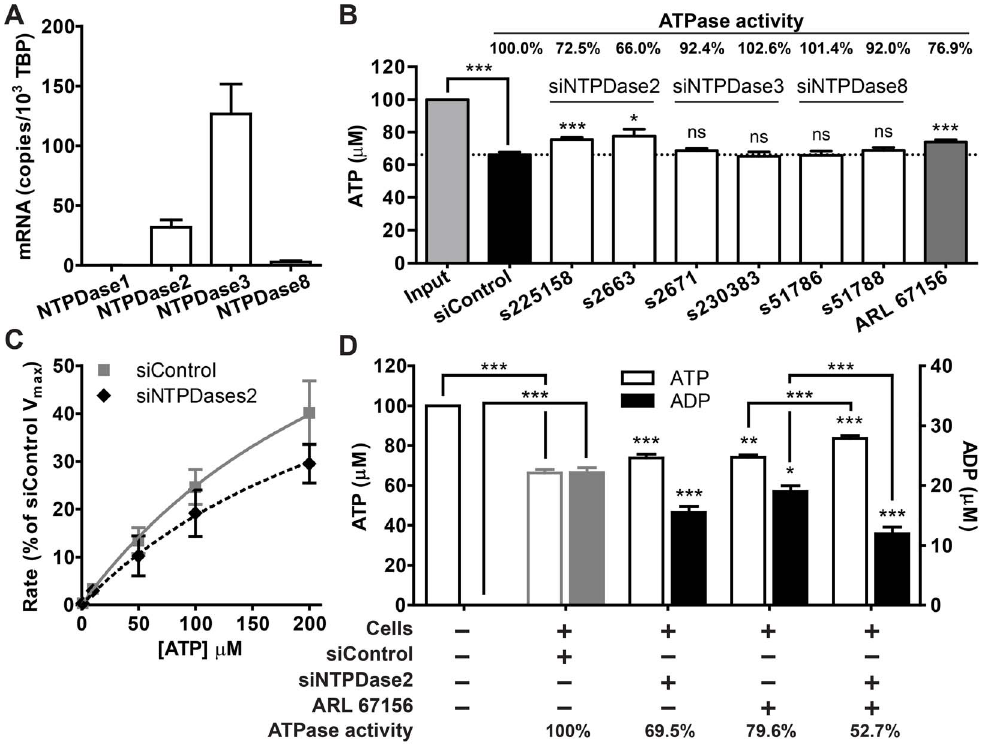
Figure 2. HaCaT cells express NTPDase2 that hydrolyzes extracellular ATP and accumulates ADP. (A) The relative mRNA levels of four surface-located NTPDases in HaCaT cells as determined using real-time PCR. Bars denote mRNA copies per 10 4 TATA-binding protein (TBP) mRNA (mean 6 SEM, n=2–21). (B) Hydrolysis of 100 m M ATP (light gray bar) when NTPDase expression is suppressed using siRNAs (white bars) or 100 m M ARL 67156, an NTPDases inhibitor (dark gray bar). ATPase activity is defined as the rate of ATP hydrolysis (amount of ATP hydrolyzed per hr) relative to the rate of control [mean 6 SEM, n=2–21, one-way ANOVA with Dunnett’s post-analysis, comparing all columns to control siRNA treatment (black bar), * p , 0.05; *** p , 0.001; ns=not significant]. (C) ATP hydrolysis kinetics in the presence of control or NTPDase2 siRNA-treated cells. Curves denote Michaelis-Menten kinetics normalized to the V max of control cells (mean 6 SEM, n=2). (D) Extracellular ATP hydrolysis and ADP accumulation when NTPDase2 was suppressed using siRNA and/or ARL 67156. Bars denote ATP (left Y-axis) and ADP (right Y-axis) concentrations compared to the respective controls (mean 6 SEM, n=5, one-way ANOVA followed by Bonferroni’s multiple comparison test, * p , 0.05; ** p , 0.01; *** p , 0.001).